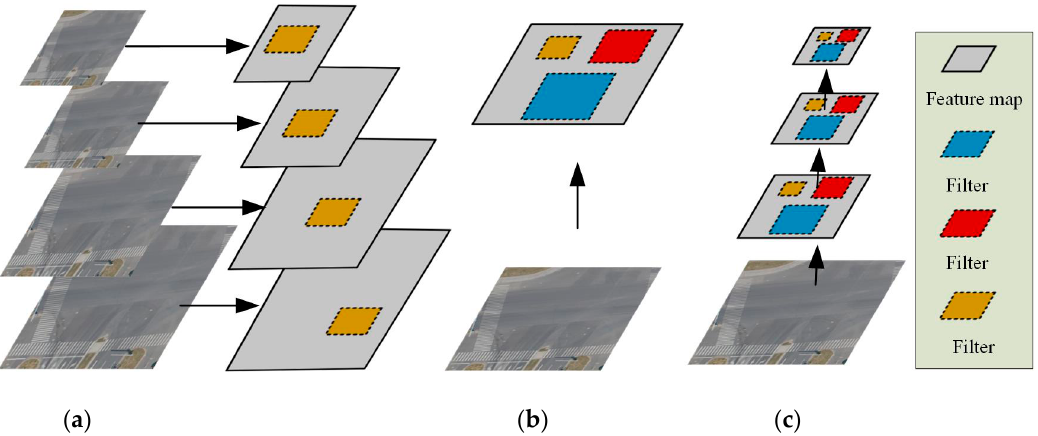
Figure 3. Different strategies for multi-level detection: ( a ) Prediction using multiple image scales with a single filter size; ( b ) Prediction using a single feature map with multiple filter sizes; ( c ) Prediction using multiple feature maps with multiple filter sizes.